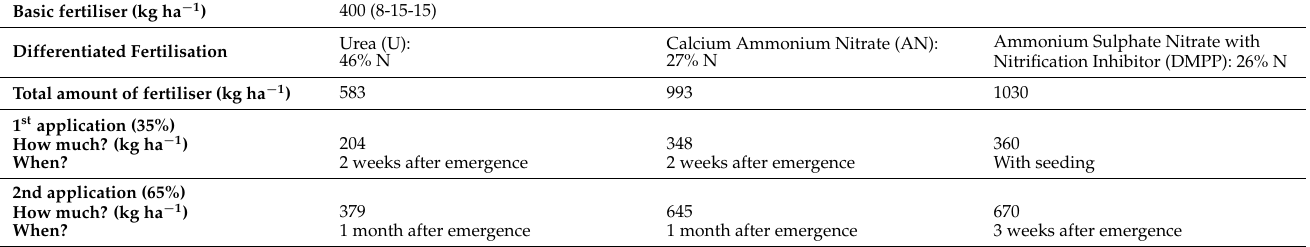
Table 2. Fertilisers used in the trial; N-richness, doses, and application dates are